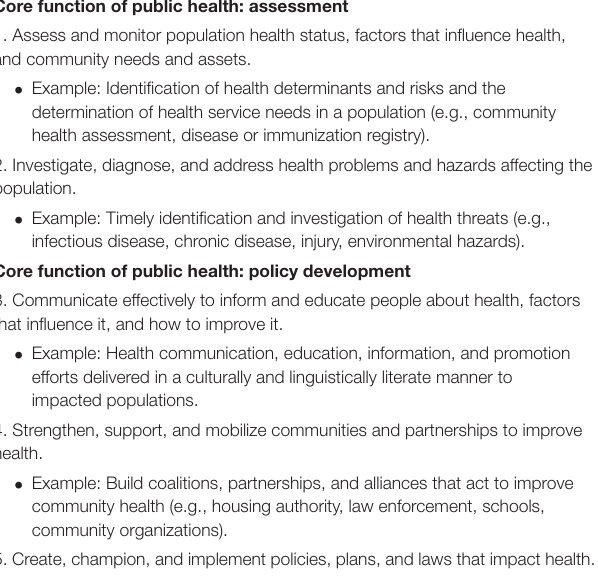
TABLE 1 | Recommendations to improve the WHO priority of “Health for All” via the CDC’s Essential Public Health Services (EPHS). Core function of public health: